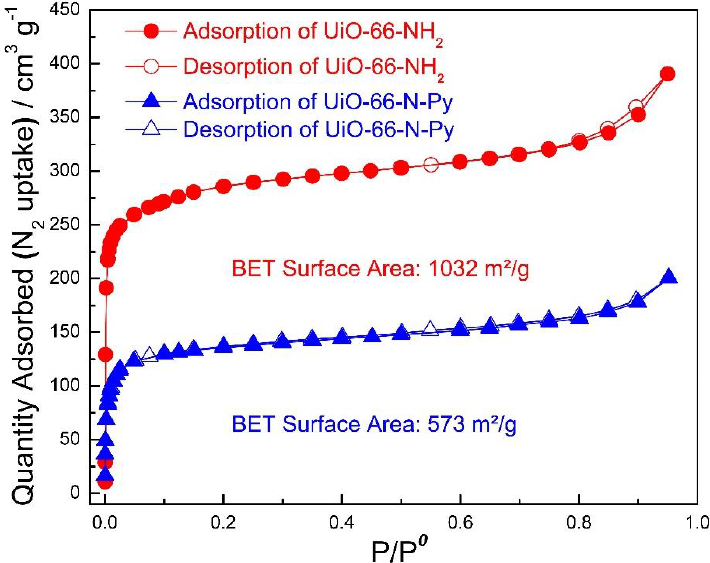
Figure 3. N 2 adsorption isotherms of UiO-66-N-Py and UiO-66-NH 2 . The filled and open circles represent the adsorption and desorption branches, respectively.